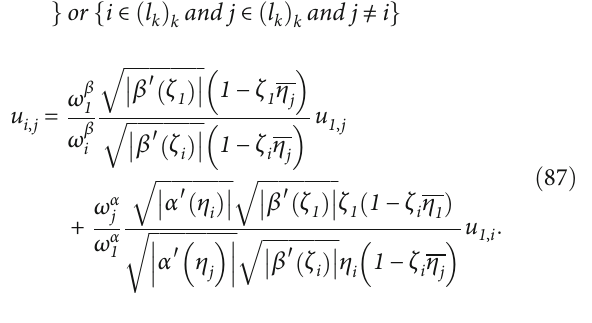
ffiffiffiffiffiffiffiffiffiffiffiffiffiffiffiffiffi q ∣ β ′ ζ ð Þ ∣ i ffiffiffiffiffiffiffiffiffiffiffiffiffiffiffiffiffiffiffi r (cid:3) (cid:4) ∣ α ′ η ∣ j